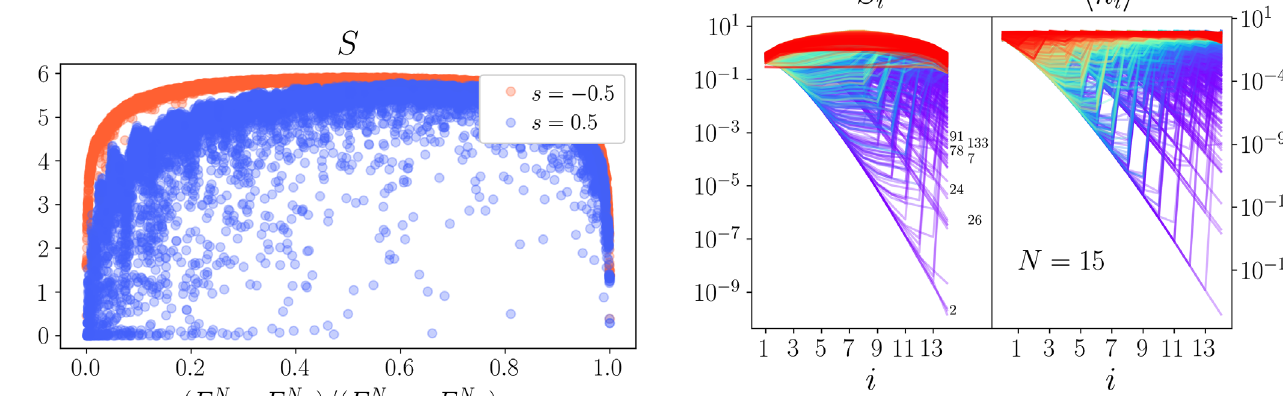
FIG. 6. Entanglement entropy of the eigenstates vs energy density, N ¼ 14 . In the two regimes of positive and negative s , the entanglement entropy of the eigenstates in the middle of the chain shows abrupt changes from normal eigenstates at s ¼ − 0 . 5 to anomalous eigenstates, where many of them have small entropy in the middle of the spectrum at s ¼ 0 . 5 .